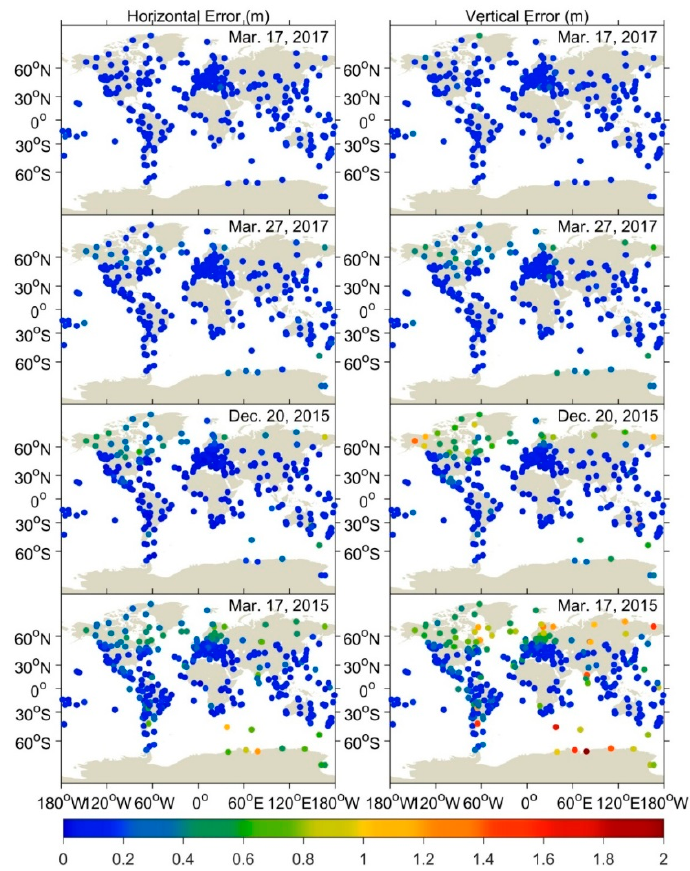
Figure 6. RMS statistics of DF PPP for worldwide GPS stations during the quiet, moderate, intense, and super storm period.